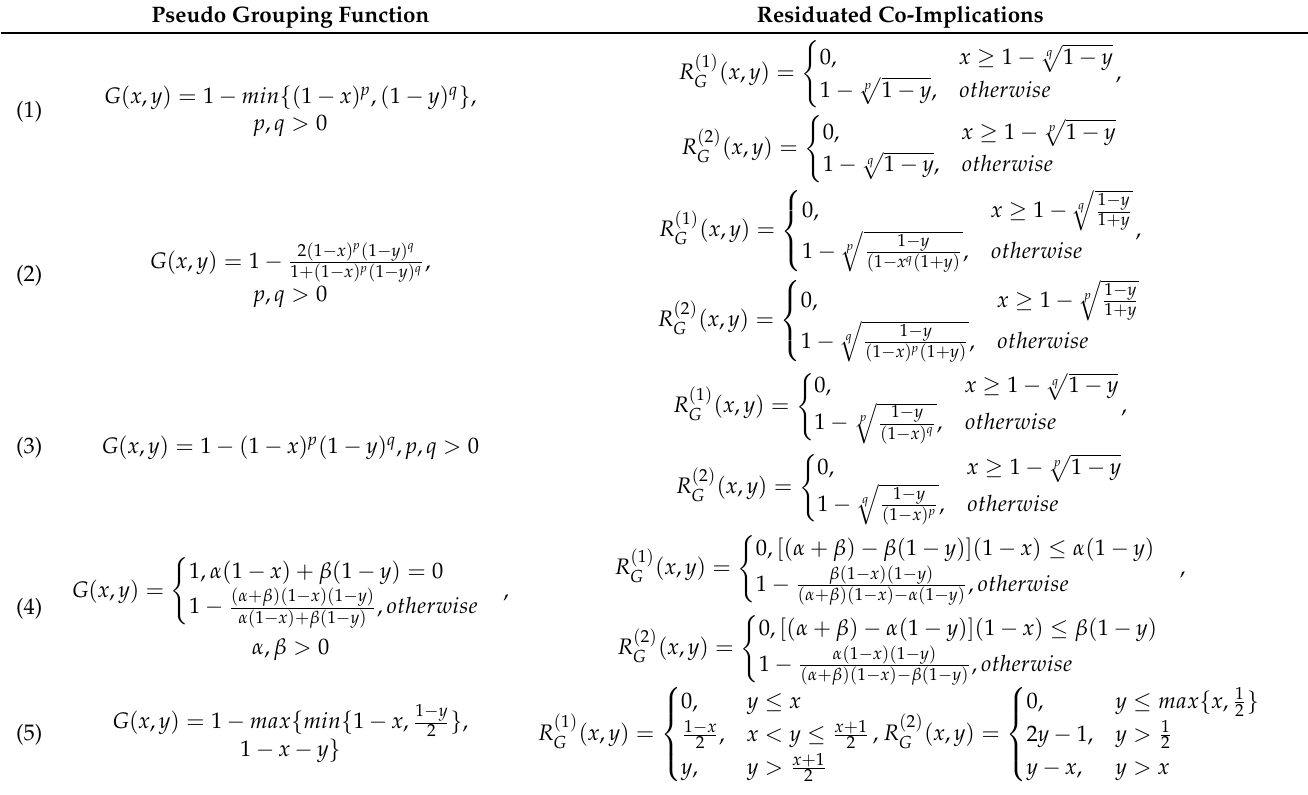
Table 2. Examples of pseudo grouping functions and their residuated co-implications. Pseudo Grouping Function Residuated